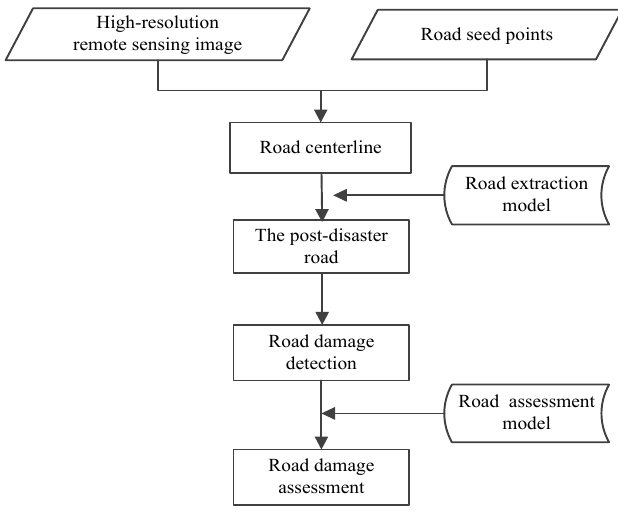
Figure 1. Flow chart of road damage detection and